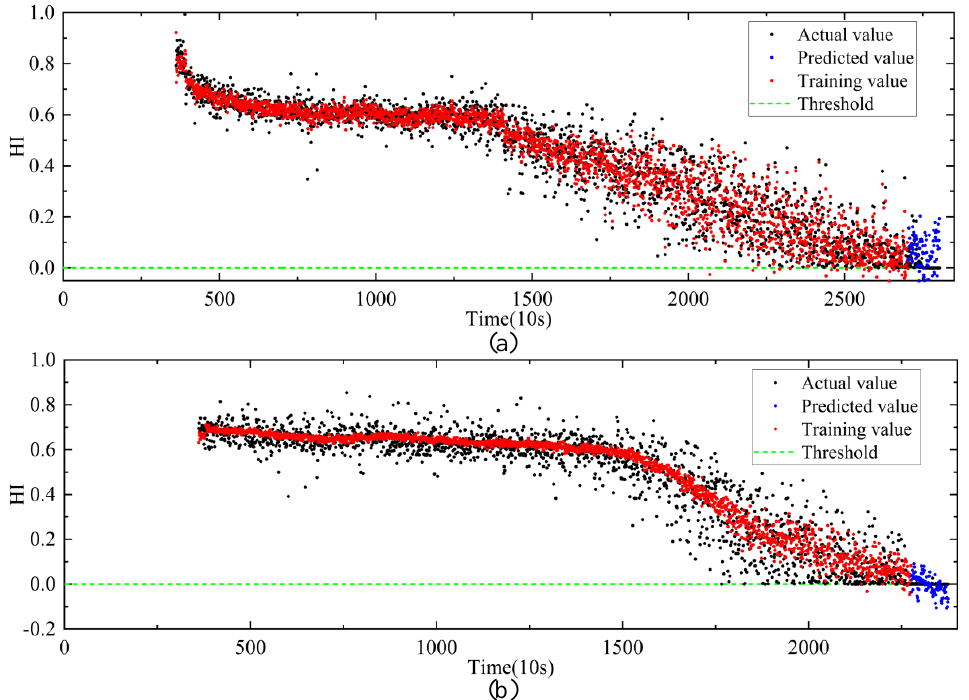
Figure 14. RUL prediction results of CNN-HI. ( a ) Bearing1_1. ( b ) Bearing1_3.